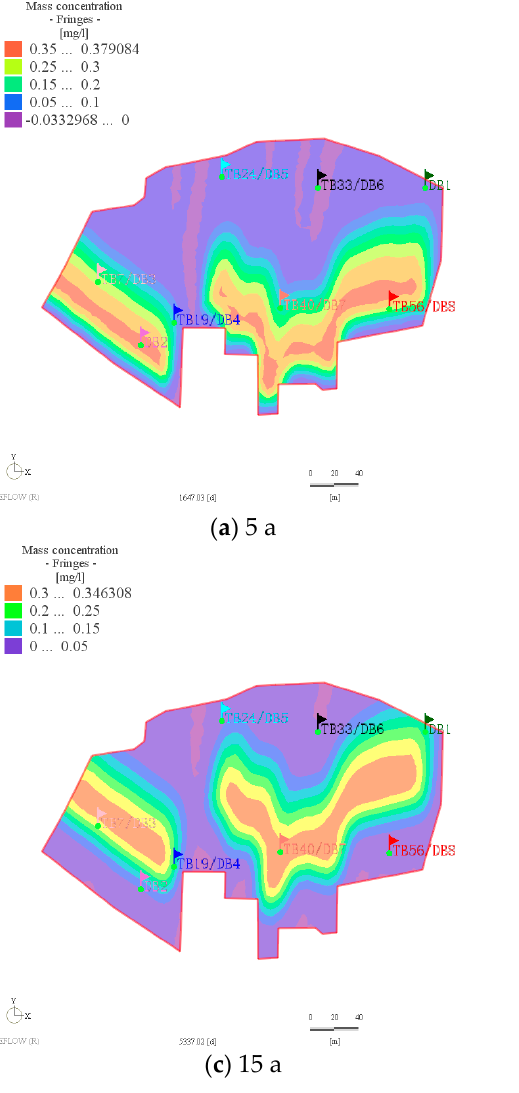
Figure 8. Pollutant transport in the simulation area after the implementation of engineering measures: change of pollutant concentration in groundwater during ( a ) 5, ( b ) 10, ( c ) 15 and ( d ) 20 years.